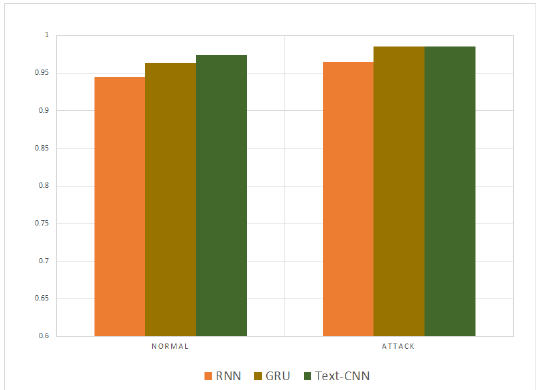
Figure 14. F1-Score of the entire ADFA-LD